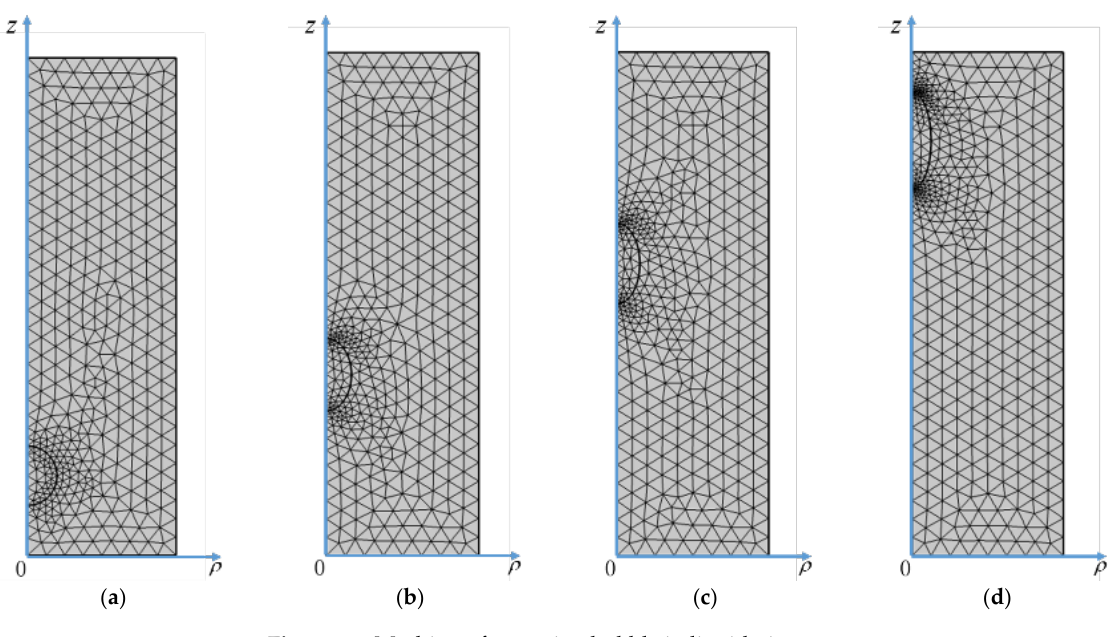
Figure 11. Meshing of a moving bubble in liquid nitrogen.